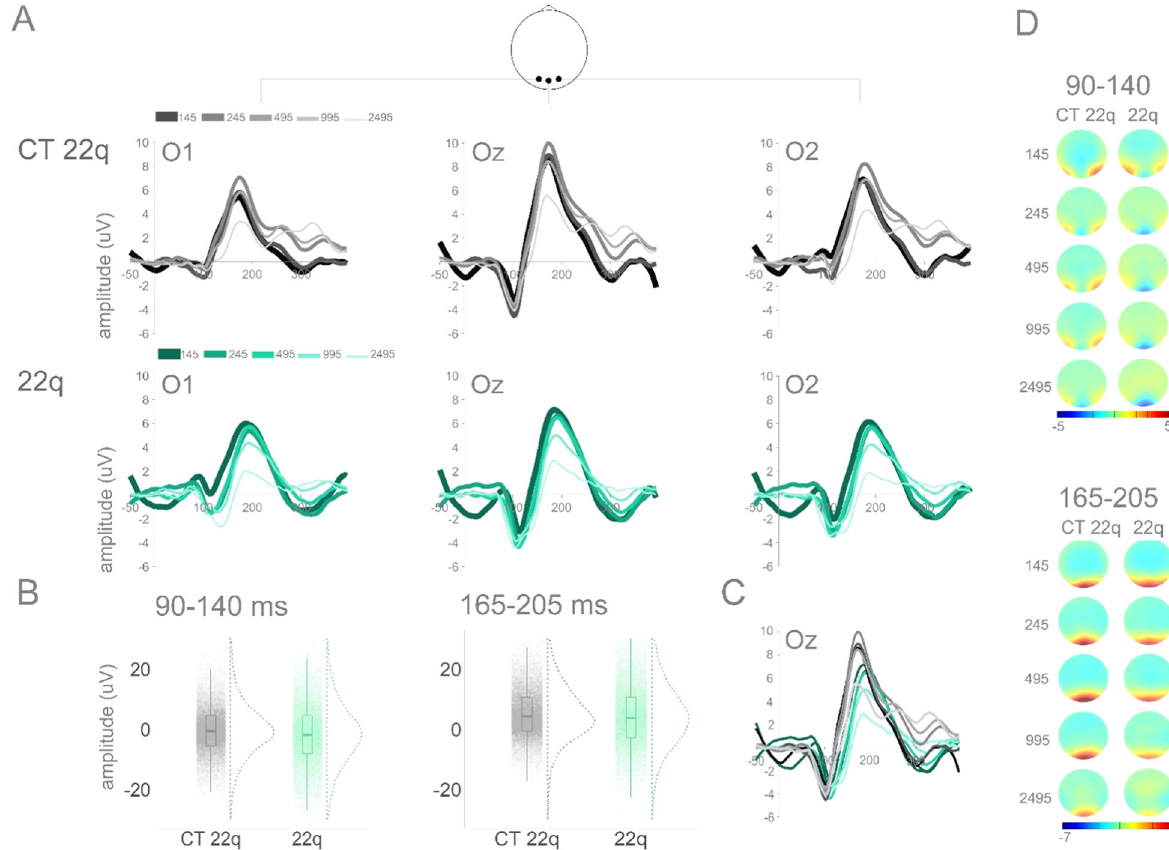
Fig. 2 CT 22q and 22q: Averaged ERPs and topographies per group and ISI. A Averaged ERPs per group (CT 22q and 22q) and ISI at O1, Oz, and O2. B Plots showing distribution of amplitudes (trial-by-trial data; average of O1, Oz, and O2) for the time windows of interest (90 – 140 ms and 165 – 205 ms). C Averaged ERPs for both groups at Oz. D Topographies for windows of interest per group and